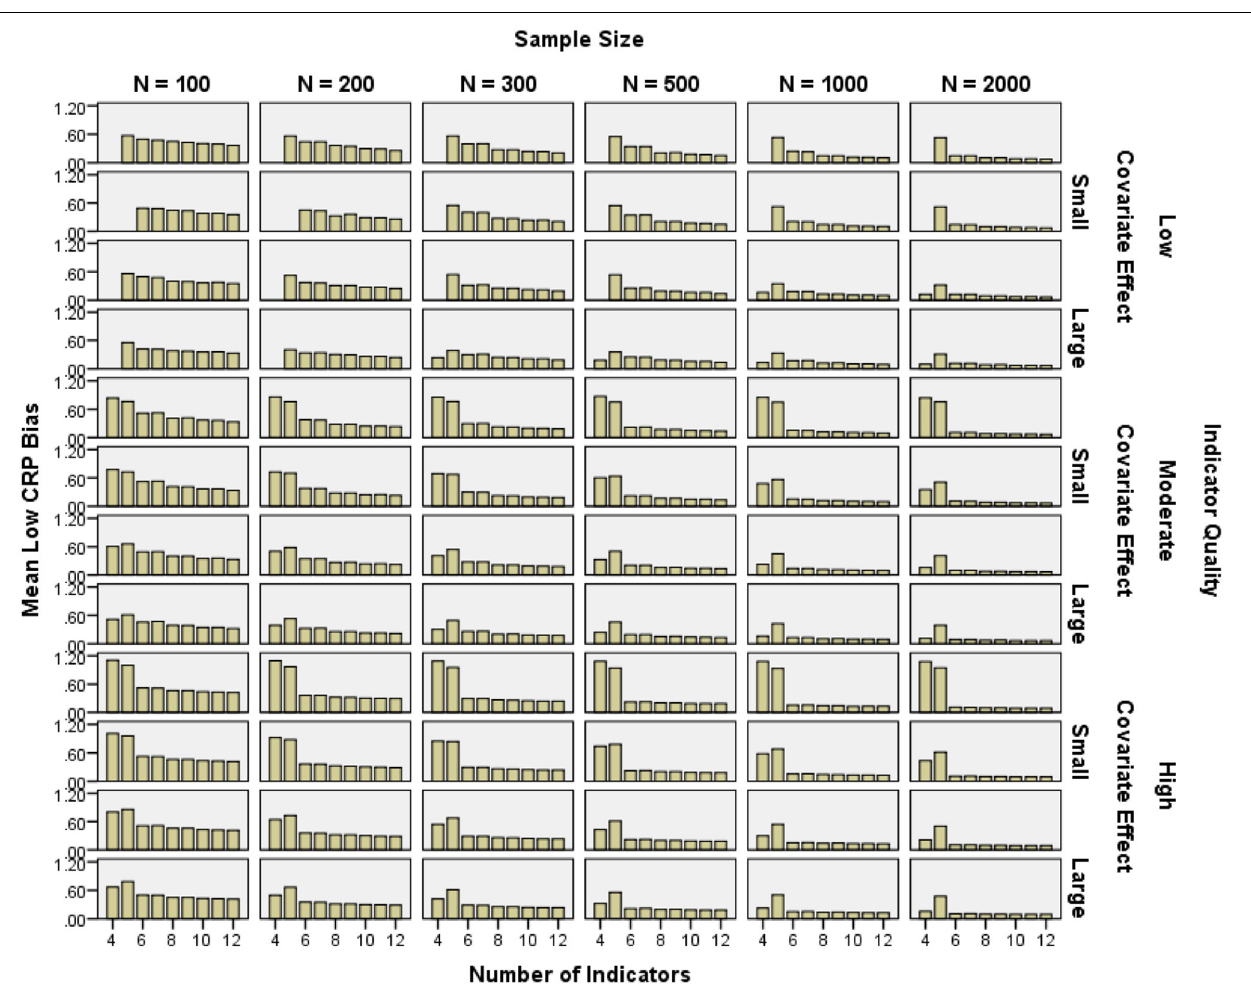
FIGURE 7 | Mean low conditional response probability relative bias by number of indicators, indicator quality, covariate effect size, and sample